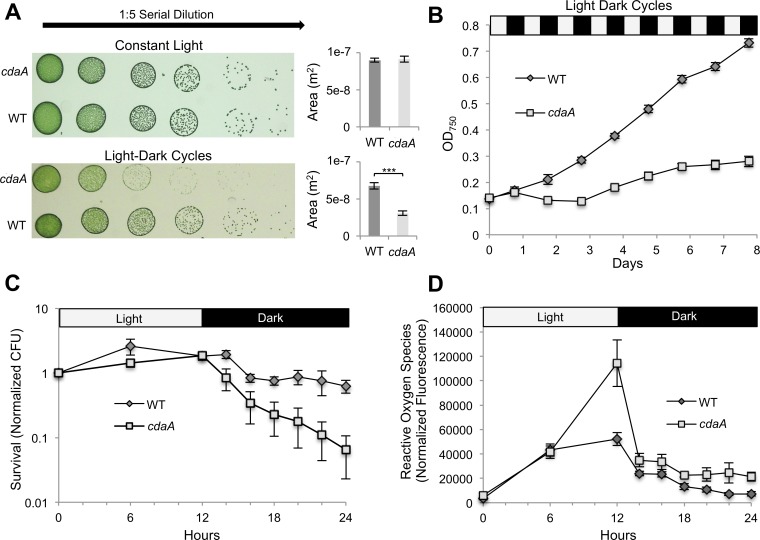
Sensitivity of cdaA mutant to LDCs.(A) Growth of WT and cdaA transposon mutant (8S16-L9) measured by spot plate under constant light and LDCs. ***P < 10−5 (Mann-Whitney-Wilcoxon Test). (B) Growth curve of WT and cdaA mutant in liquid culture in bioreactors under LDCs. (C) High resolution measurement of survival of WT and cdaA mutant throughout one LDC. Survival is quantified by CFU present at each time point normalized to CFU present at the first time point for each replicate. (D) ROS was measured by H2DCFDA fluorescence normalized by OD750. Error bars in all figure parts indicate SE of four replicates.